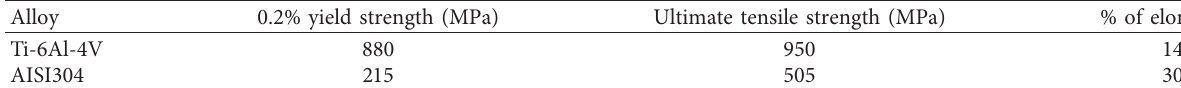
Table 2: Mechanical properties of base metals.